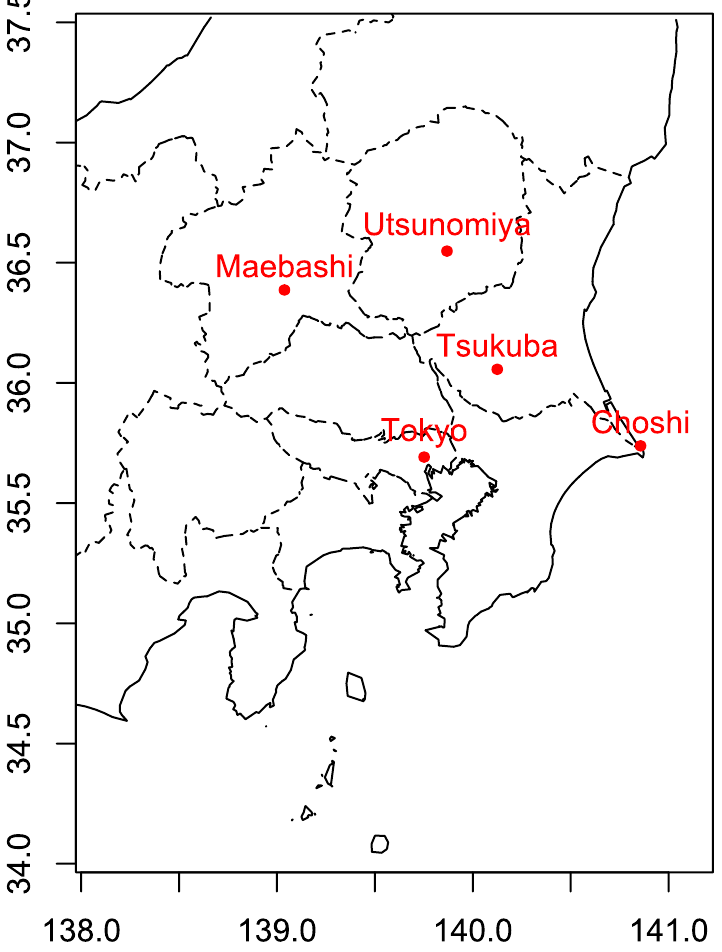
Figure 1. Location of the JMA Stations. JMA records ground-based observation data for GHI at 5 station in Kanto region. Maebashi, Tsukuba, Utsunomiya, Tokyo,